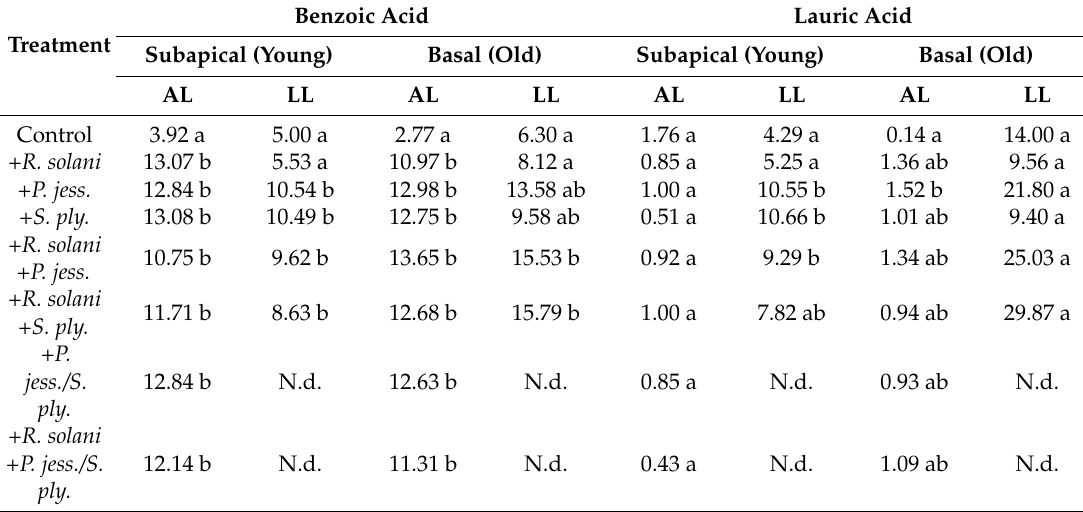
Benzoic and lauric acid concentrations in rhizosphere soil solutions collected by micro-sampling with sorption filters in 1–2 cm subapical regions of young roots and from older basal root zones (8–9 cm) of Lactuca sativa L. cv. Tizian. The plants were grown on alluvial loam treated without (control), with Rhizoctonia solani (+ R. solani ), with Pseudomonas jessenii ( +P. jess. ) and Serratia plymuthica ( +S. ply. ), with Rhizoctonia solani and one bacterial inoculant (+ R. solani +P. jess ; +R. solani +S. ply. ), with a combination of both bacterial inoculants ( +P. jess / S. ply. ) and with Rhizoctonia solani and both bacterial inoculants (+ R. solani +P. jess./S. ply. ). Relative values based on peak areas (gas chromatography-mass spectrometry (GC-MS) analysis) after subtraction of background levels in bulk soil